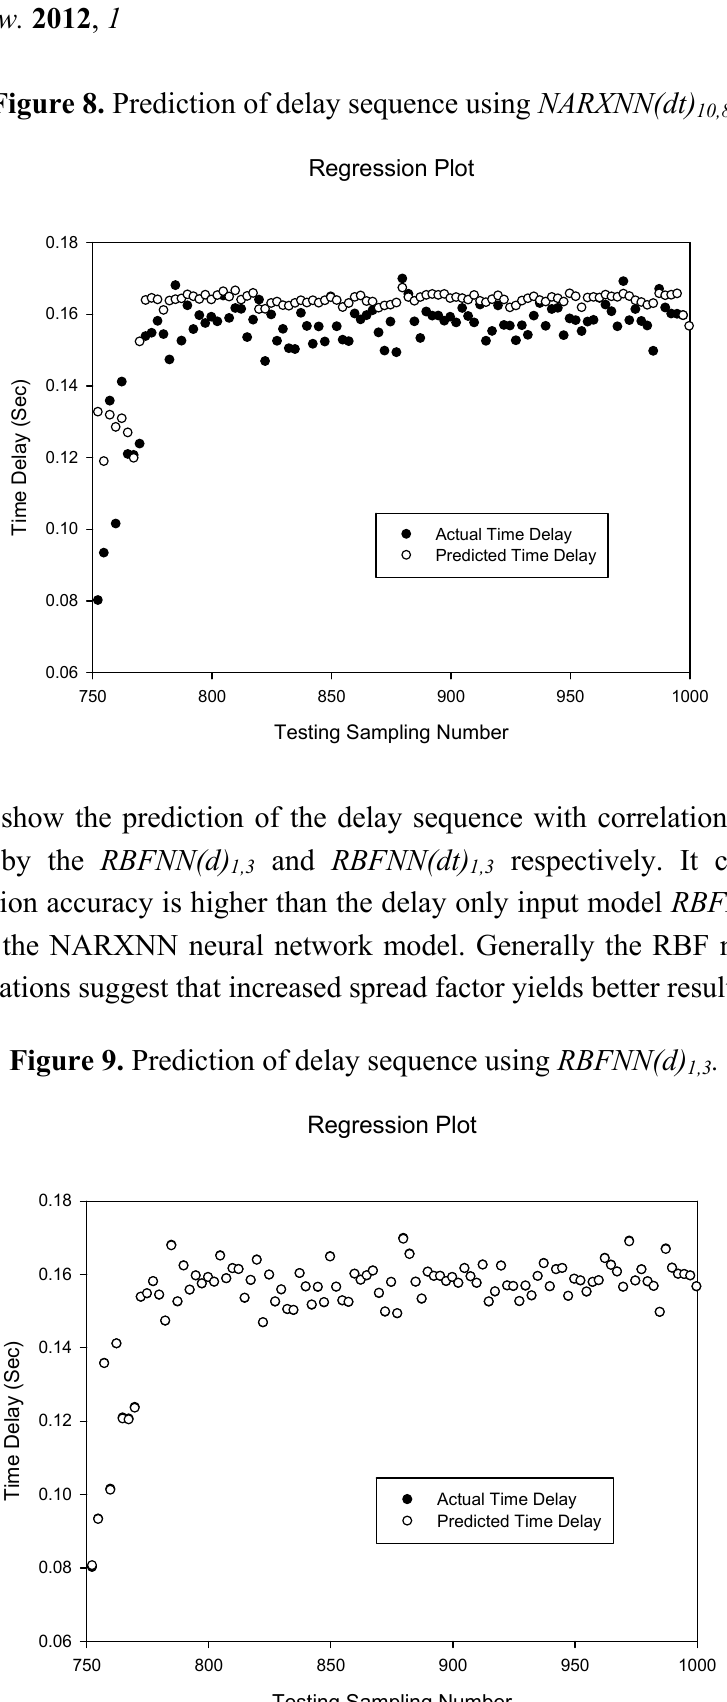
Figure 8. Prediction of delay sequence using NARXNN(dt)